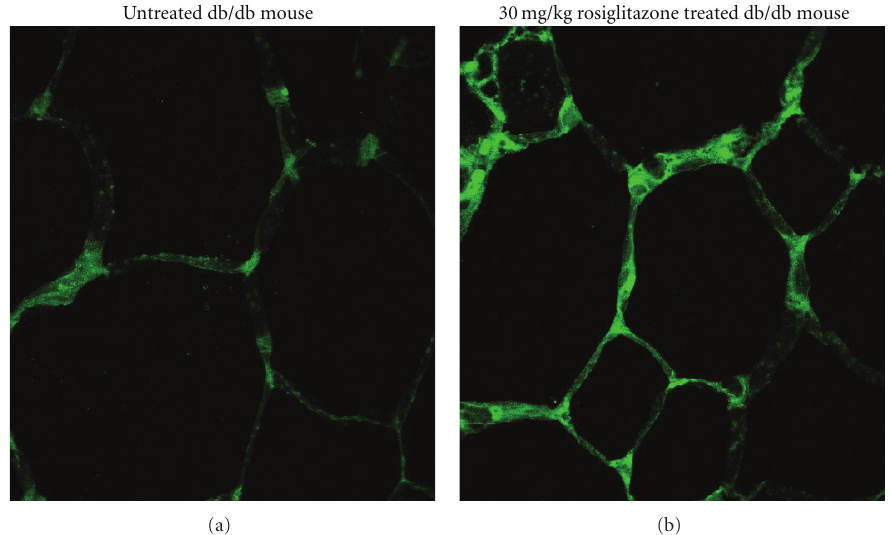
Figure 5: Immunochemical detection in db/db and RSG-treated db/db of the IAT OxPhos complex IV subunit I. IAT from untreated db/db (a) and from 30mg/kg RSG-treated db/db (b) were isolated, fixed on slide, and stained with anti-OxPhos complex IV subunit I. Nuclei were identified with Hoechst